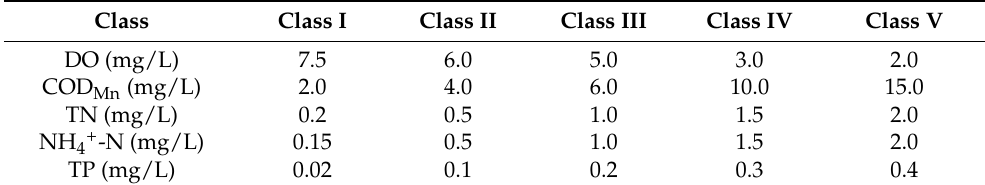
Table 2. National Standard of Surface Water of China